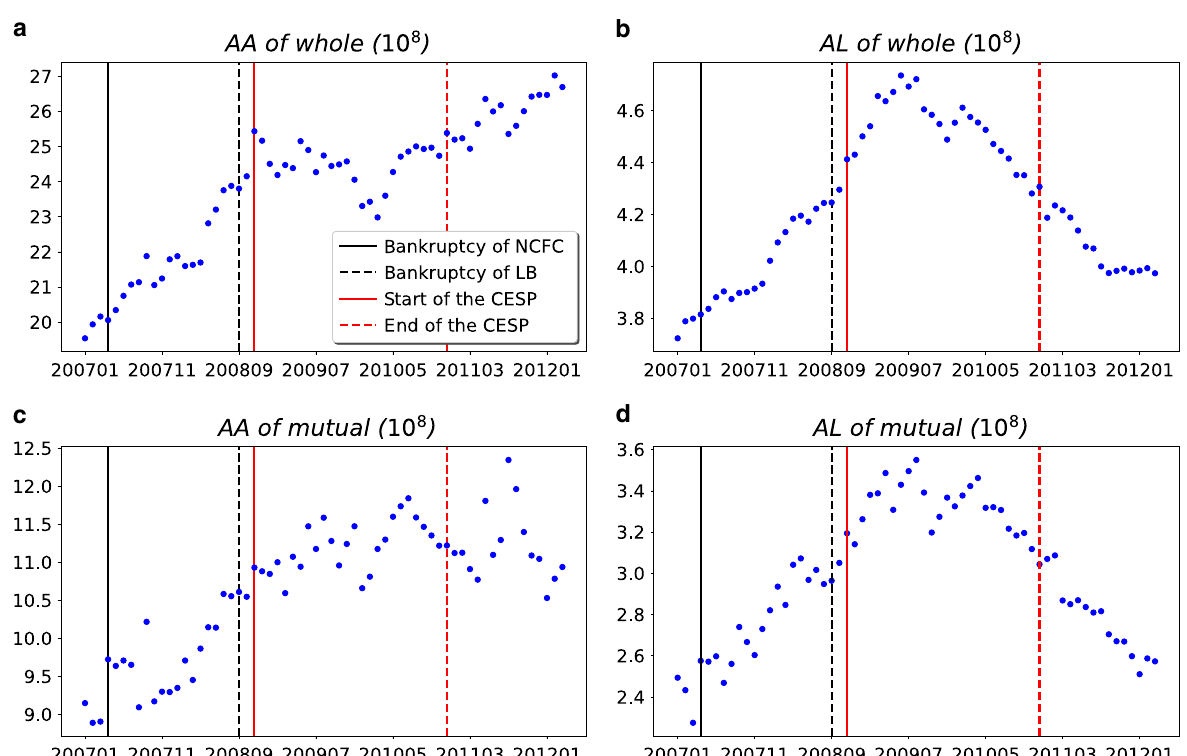
Fig. 3 Dynamics of fi nancial characteristics of fi rms in the guarantee network. a AA of whole: average fi rms ’ asset of whole guarantee network. b AL of whole: average fi rms ’ loan of whole guarantee network. c AA of mutual: average fi rms ’ asset with mutual guarantee. d AL of mutual: average fi rms ’ loan with mutual guarantee. Source data are provided as a Source Data fi